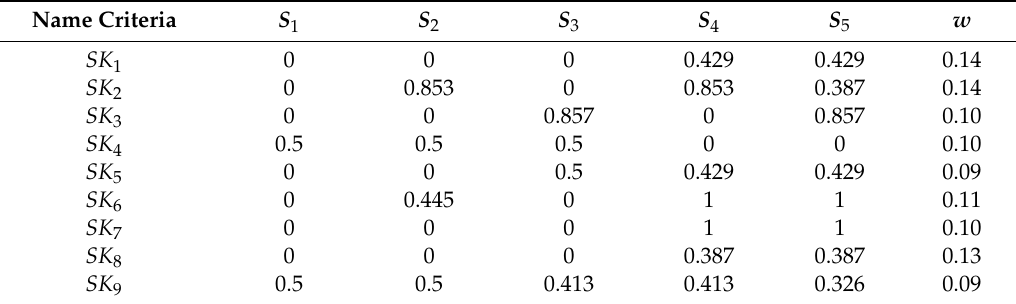
Table 6. Values of assessments by evaluation